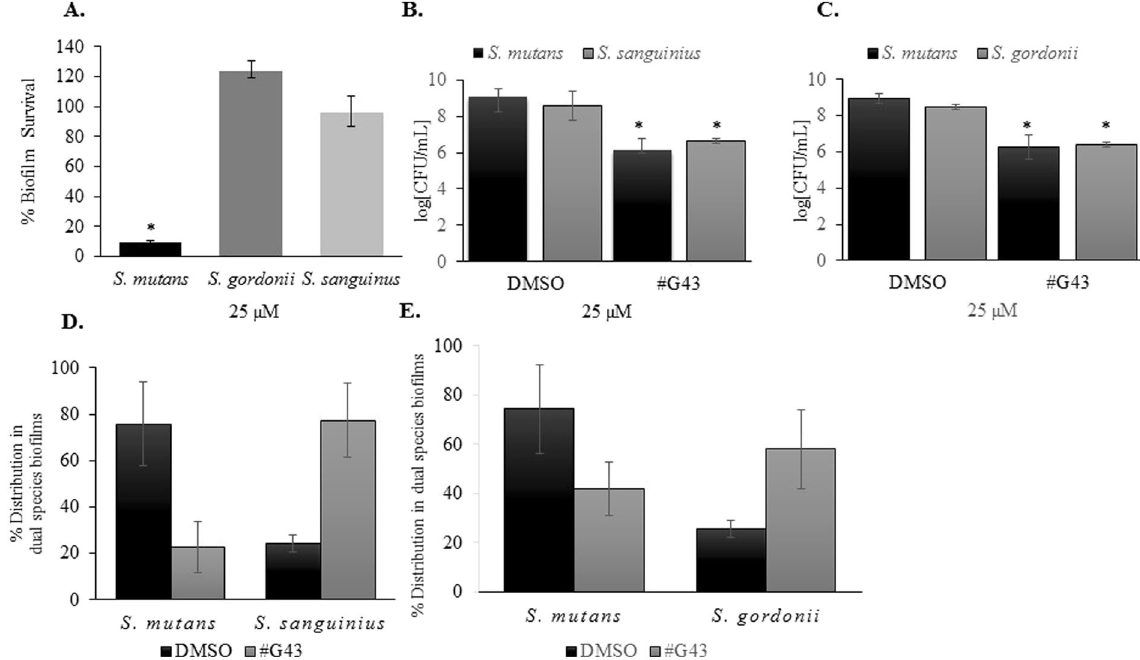
Figure 6. Effects of compound #G43 on commensal single and dual species biofilms. ( A ) S. mutans , S. gordonii , and S. sanguinis were treated with DMSO or 25 µ M of compound #G43, and the biomasses of each treated biofilm were quantitated by crystal violet staining and measured at OD 562 . ( B ) The cell viability of dual species biofilms was determined by the numbers of CFU in a logarithmic scale using S. mutans , and S. sanguinis . ( C ) The cell viability of dual species biofilms was determined by the numbers of CFU in a logarithmic scale using S. mutans , and S. gordonii . ( D ) Species distribution in dual species biofilms with S. mutans and S. sanguinius . Bars represent the mean and standard deviations of three independent experiments. ( E ) Species distribution in dual species biofilms with S. mutans and S. gordonii . Bars represent the mean and standard deviations of three independent experiments. * P <